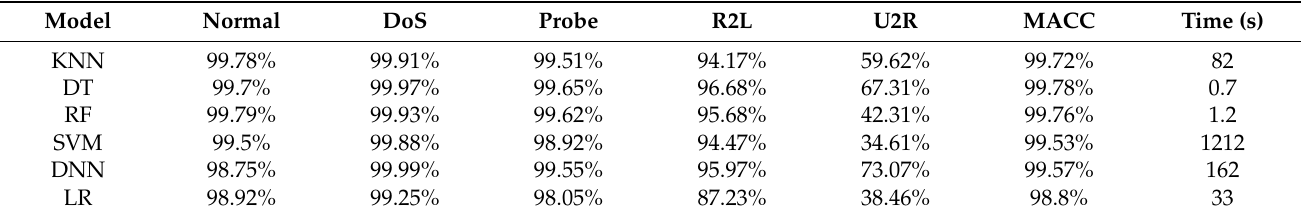
Table 5. Detection performance of cross-validate on new training set.